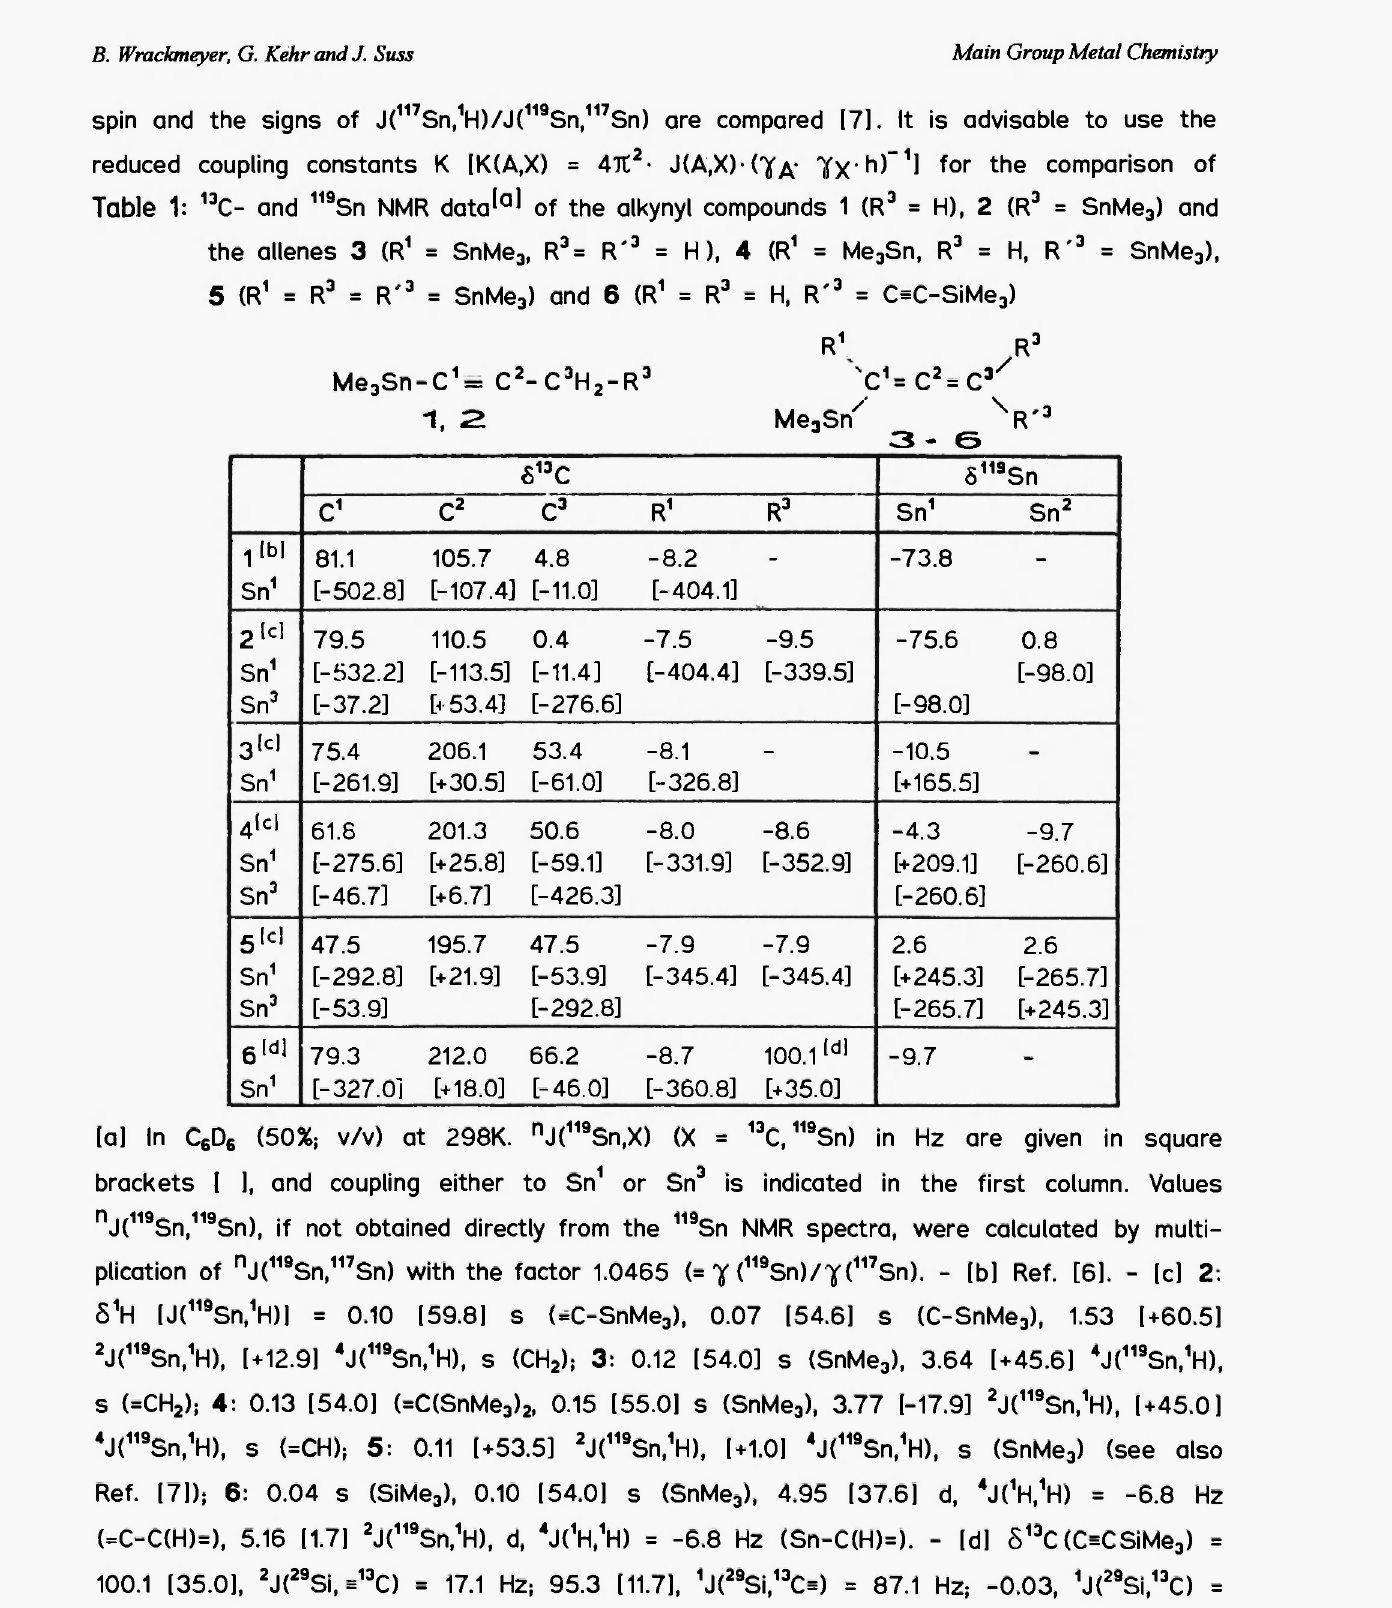
Table 1: 13 C- and 119 Sn NMR data [al of the alkynyl compounds 1 (R 3 = H), 2 (R 3 = SnMe 3 ) and the allenes 3 (R 1 = SnMe 3 , R 3 = R' 3 = H), 4 (R 1 = Me 3 Sn, R 3 = H, R' 3 = SnMe 3